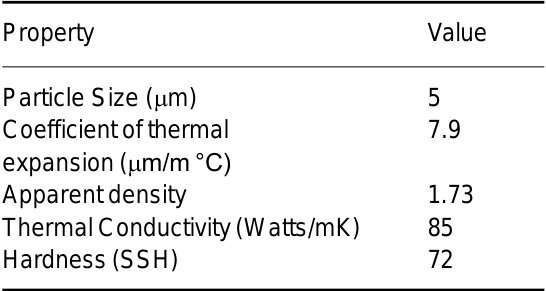
Table 2. Physical properties of the semiconductor grade graphite plates used in the